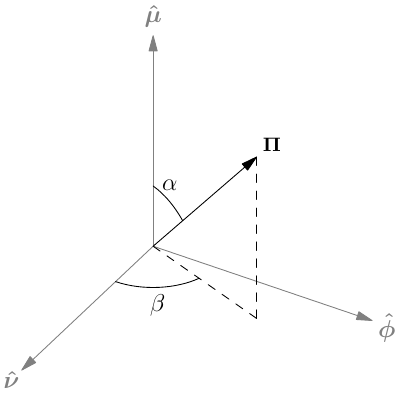
Fig. 10: Angles specifying the orientation of the Poynting vector with respect to the MFA coordinate axes.